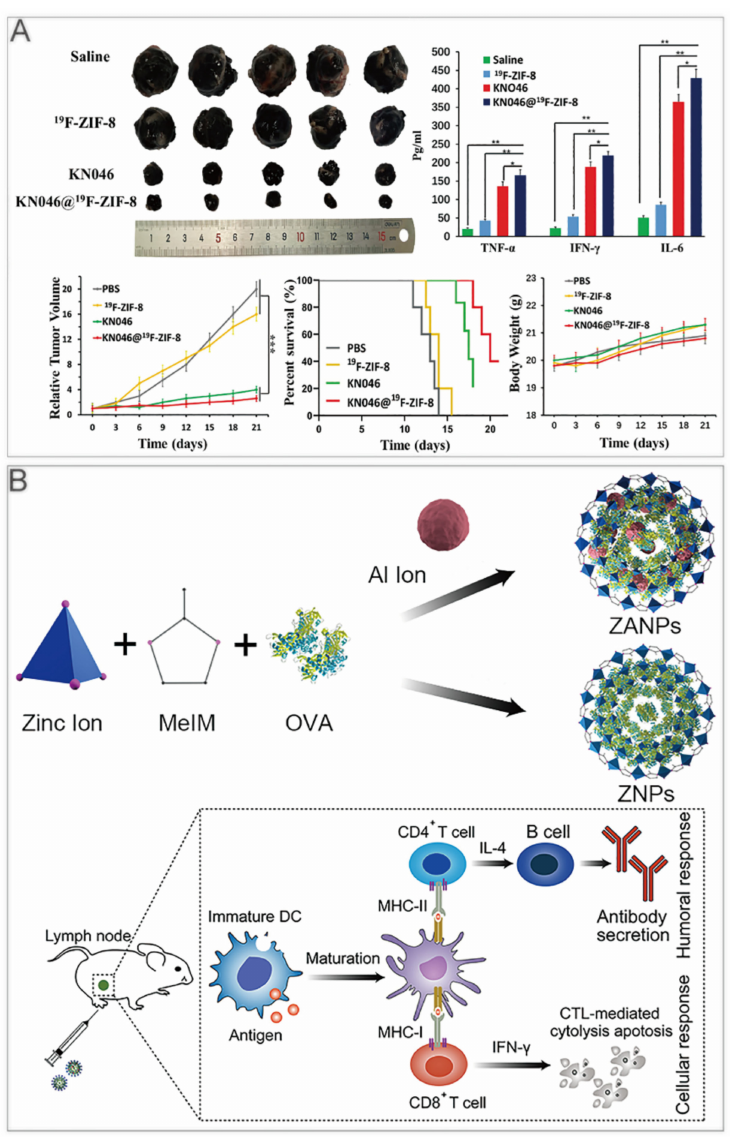
Figure 2. ZIF–8 nanoplatforms for immunotherapy. ( A ) KN046@ 19 F–ZIF–8 inhibits tumor growth